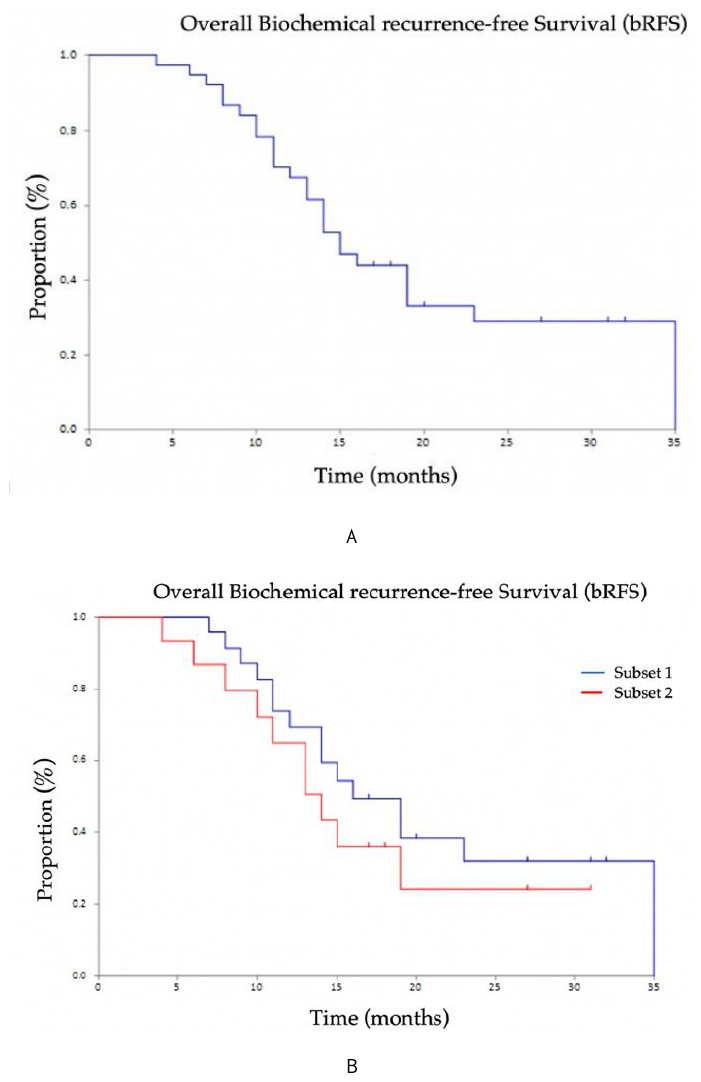
Figure 3. Kaplan–Meier curves of biochemical recurrence-free survival (b-RFS) after 68 Ga-labeled PSMA ligand PET-directed radiotherapy of prostate cancer: ( A ) overall population; ( B ) Subset 1 and Subset